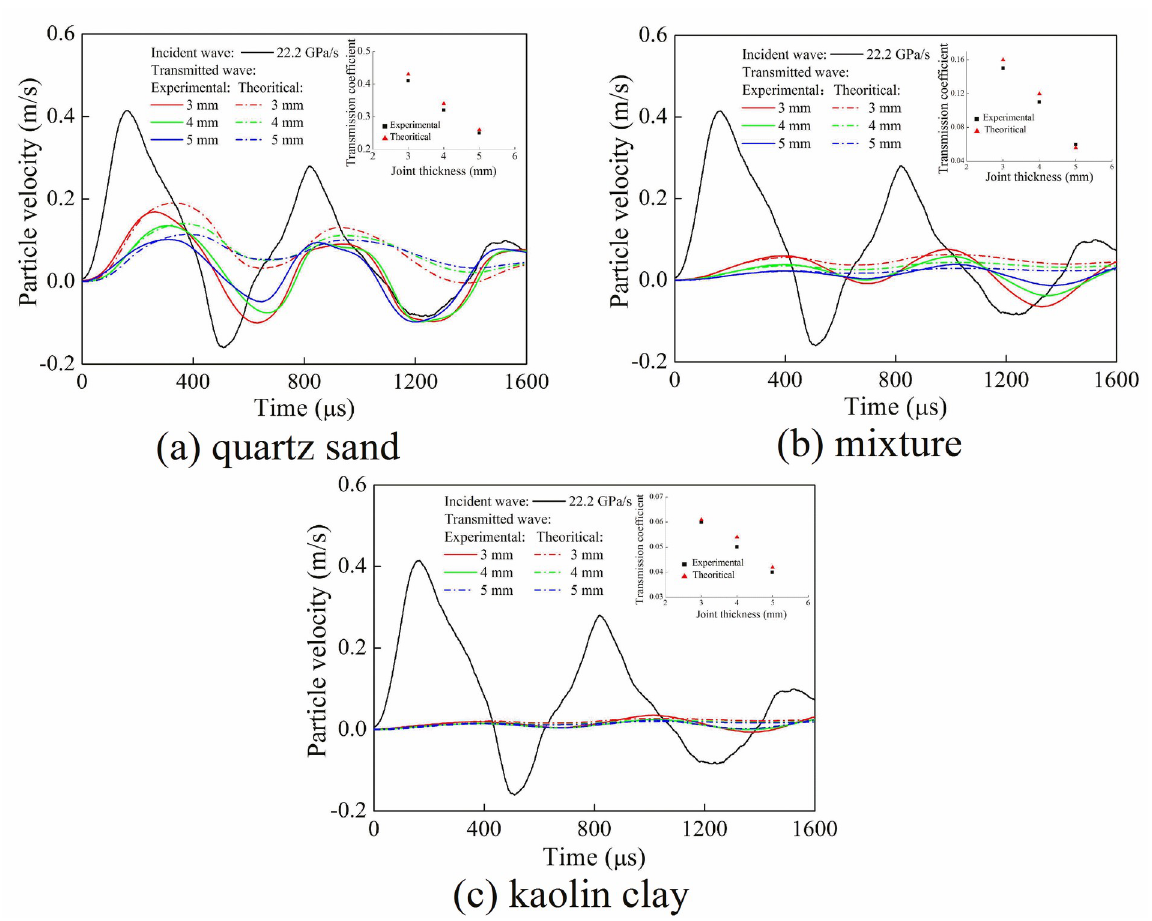
Fig 19. Time-history curves of particle velocity of transmitted waves under different joint widths. (a) quartz sand (b) mixture (c) kaolin clay.